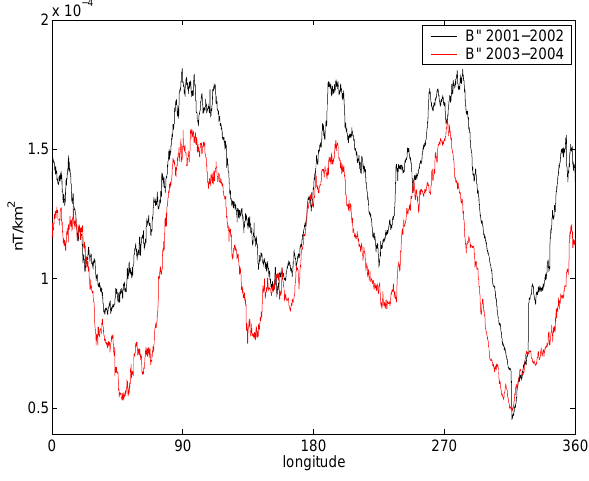
Fig. 9. Comparison of the longitude profiles of the equatorial electrojet field, longitudinal component (in nT/km 2 ), obtained from 2001-2002 data only (in black) and 2003-2004 data only (in red).